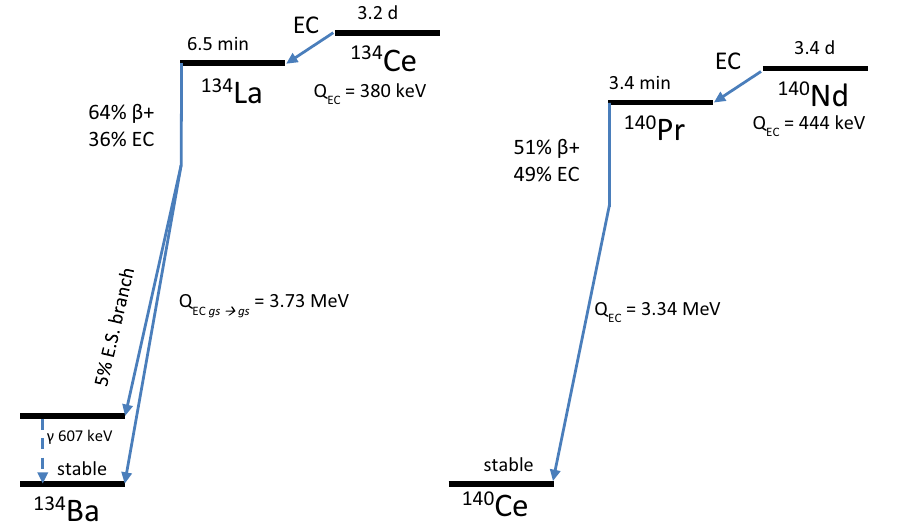
Figure 1. Simplified decay schemes for the 134 Ce and 140 Nd decay